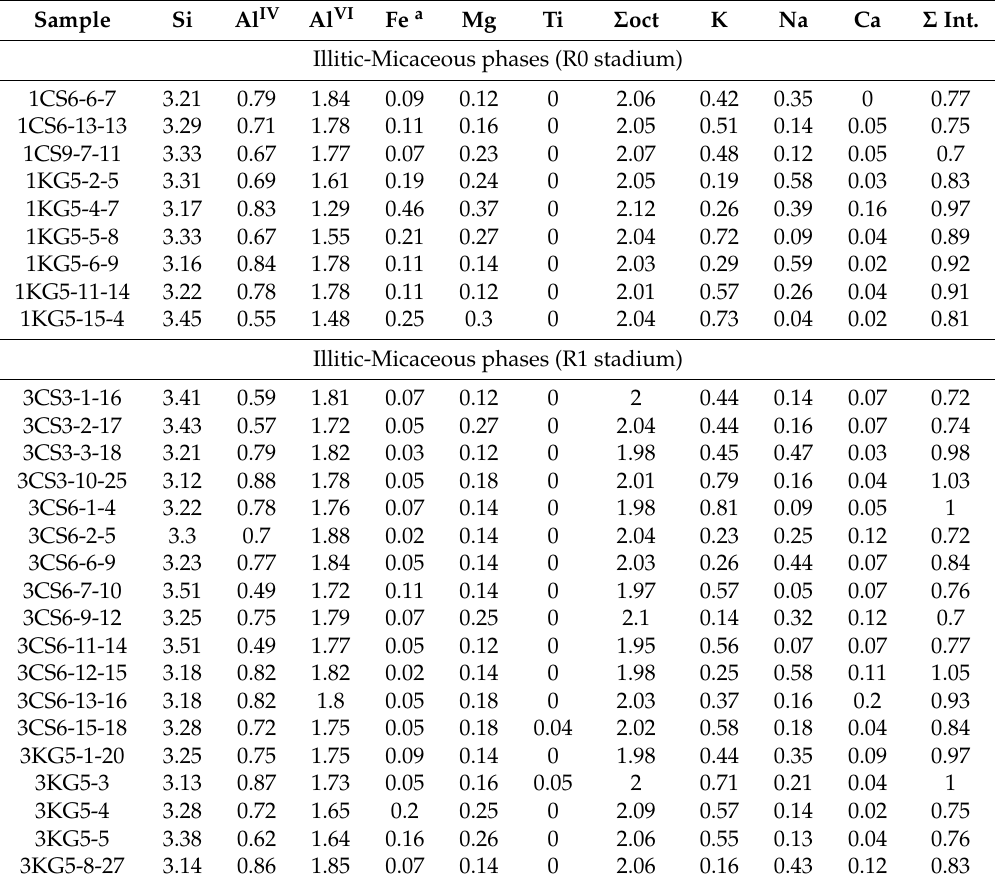
Table 1. Chemical composition of micaceous phases determined by